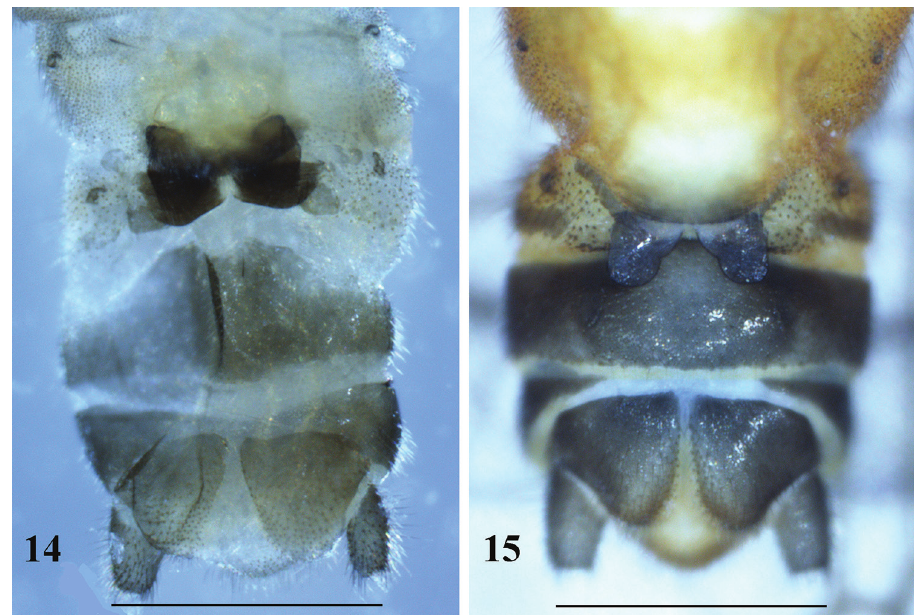
Figures 14, 15. Female terminalia in ventral view 14 Amphinemura albicauda sp. n., paratype 15 Am- phinemura dingoidea sp. n., paratype. Scale bar: 0.5